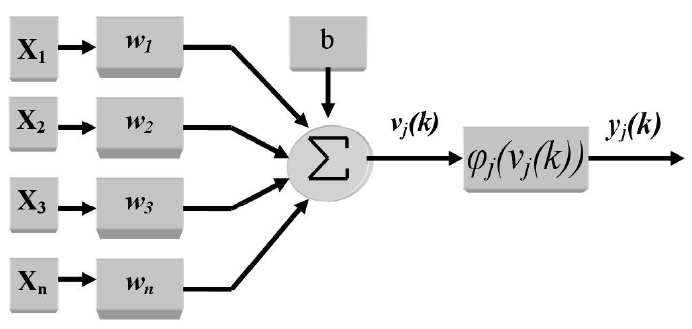
Figure 1. Schematic representation of an artificial